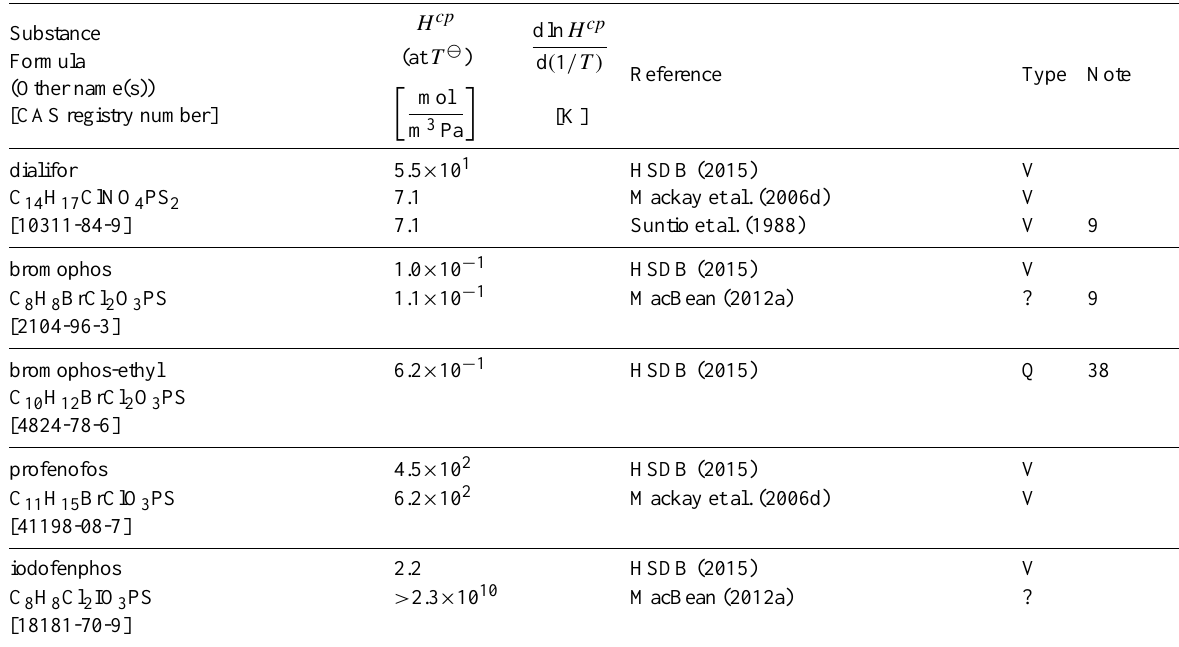
Table 6: Henry’s law constants for water as solvent